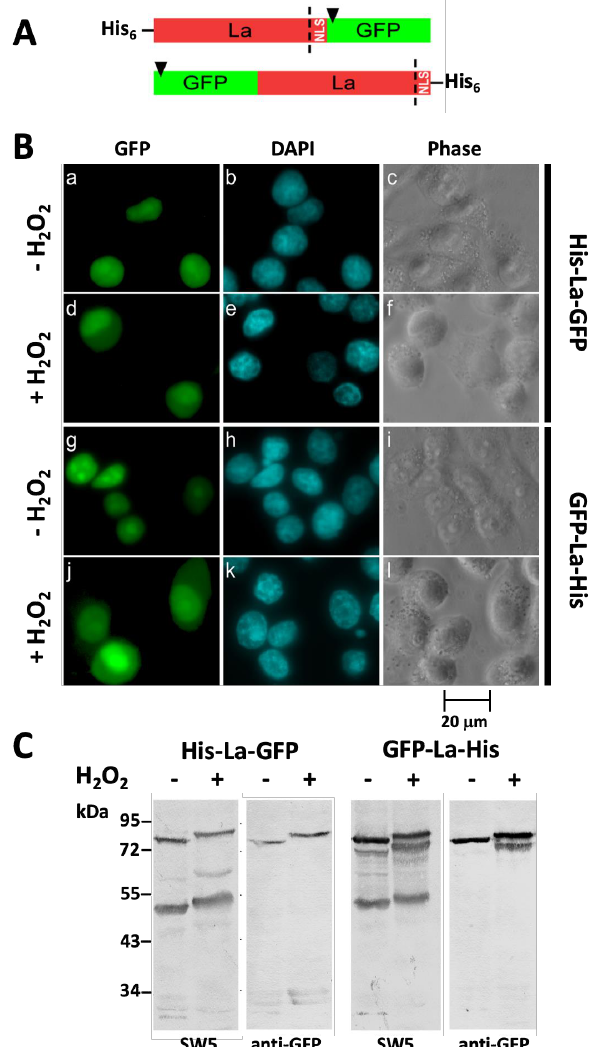
Figure 2. La protein is not cleaved under oxidative conditions. ( A ) La protein contains potential proteolytic cleavage sites (dashed line) upstream of the nuclear location signal (NLS). Two different GFP–La-His fusion proteins were constructed in which GFP is fused either upstream or downstream of the La reading frame. In case GFP is fused to the N-terminus of La protein, a His-Tag is fused to the C-terminus of La protein resulting in the fusion protein GFP–La-His. In case GFP is fused to the C-terminus of La protein a His-Tag is fused to the N-terminus of La protein resulting in the fusion protein His-La-GFP. ( B ) Human HeLa cells expressing either the His-La-GFP fusion construct ( a – f ) or the GFP–La-His fusion construct ( g – l ). Cells were either untreated ( a – c ; g – i ) or treated with H 2 O 2 ( d – f ; j – l ). (C) SDS-PAGE and immunoblotting of total extracts from cells expressing either the His-La-GFP fusion construct ( His-La-GFP ) or the GFP–La-His fusion construct ( GFP-La-His ). Total extracts were blotted against either the anti-La mAb SW5 ( SW5 ) or an anti-GFP Ab ( anti-GFP ). Extracts were obtained from transfected cells which were either untreated (-) or treated with H 2 O 2 (+) prior to the preparation of the extracts.